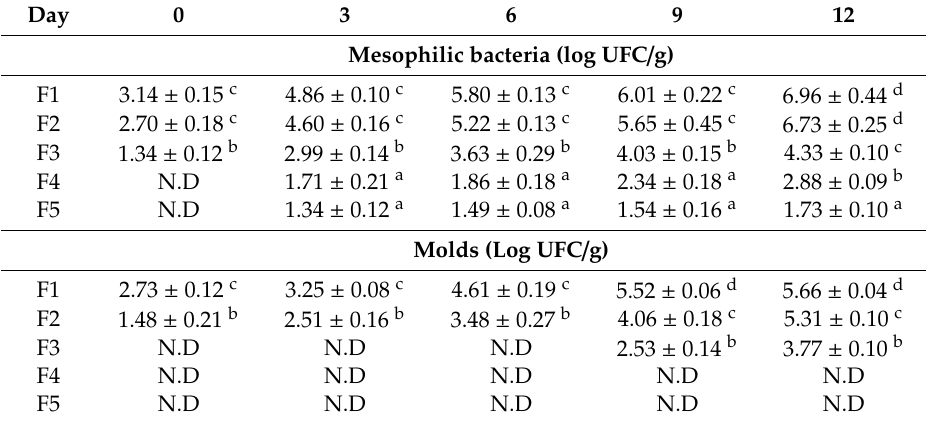
Table 6. E ff ect of treatments on the concentration of aerobic mesophilic and counting of molds in tomatoes with CS + RGEO treatments: F1 = control, F2 = CS, F3 = CS + RGEO 0.5%, F4 = CS + RGEO 1.0%, and F5 = CS + RGEO 1.5%. Mean values and intervals of LSD 95% according